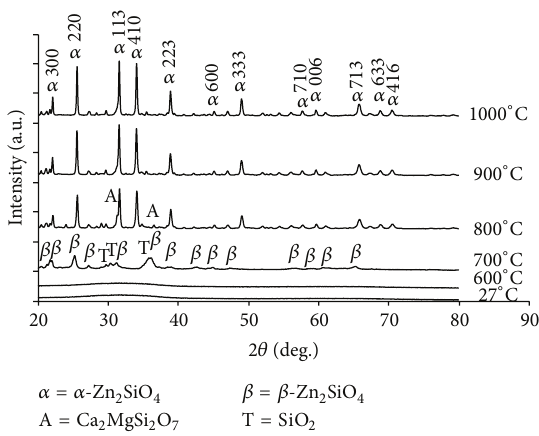
Figure 2: X-ray diffraction of the sample at various heat treatment